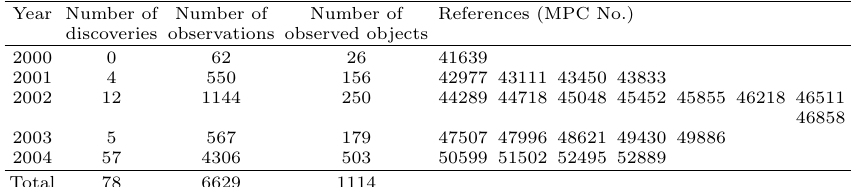
Table 1. Distribution of discoveries of asteroids and numbers of their astrometric observations per year. Year Number of Number of Number of References (MPC No.) discoveries observations observed